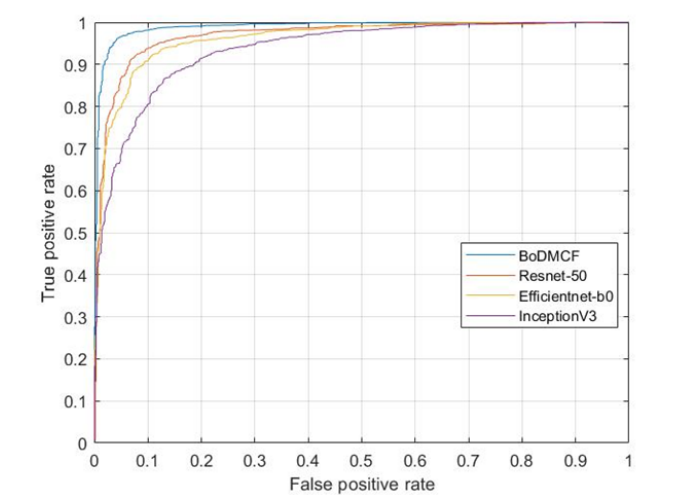
Figure 12. ROC Curves for our